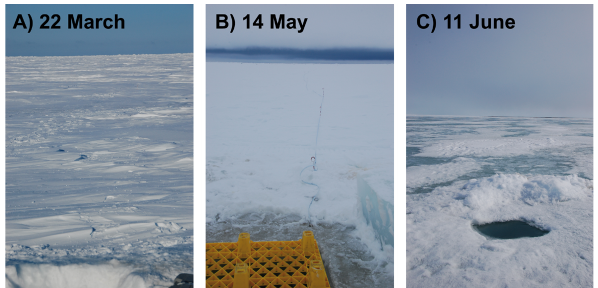
Fig. 2. Photographs of surface conditions along profiles in (a) March, (b) May, and (c) June 2010. All photographs were taken af- ter completion of the measurements, which were performed under undisturbed surfaces. The snow pile next to the hole in June resulted from the hole construction. This part was removed for analyses.